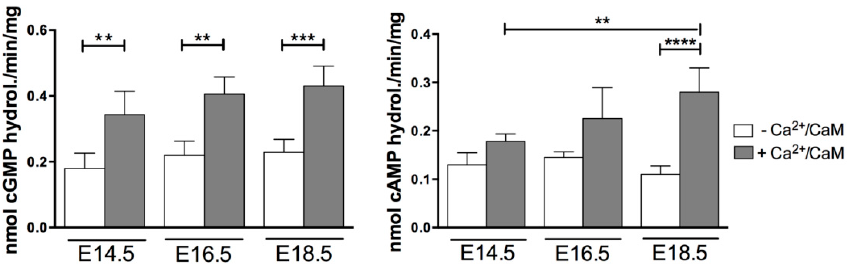
Figure 4. PDE1 enzymatic activity during the heart formation. Total PDE1 activity evaluated with cGMP as substrate in the presence of calcium and calmodulin. PDE1C activity assessed with 0.1 μ M cAMP as substrate in the presence of calcium and calmodulin. Data represent the mean of three independent experiments ± SD. Each experiment was performed with a pool of 5 hearts per stage. Two-way ANOVA were used for statistical analysis. ** p < 0.01, *** p < 0.001, **** p < 0.0001. Since there are no specific inhibitors to PDE1 isoforms but PDE1C has a higher af- finity for cAMP with respect to the other two isoforms [23], its hydrolyzing activity was evaluated in the presence of 0.1 μ M cAMP (Figure 4). The results obtained showed a